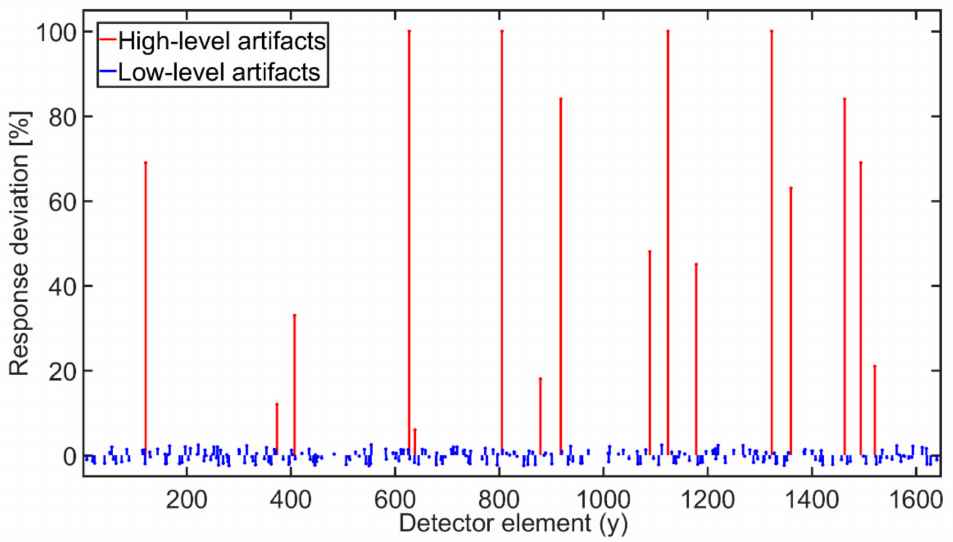
Figure 5. Example of simulated response deviations of detector elements representing the ring